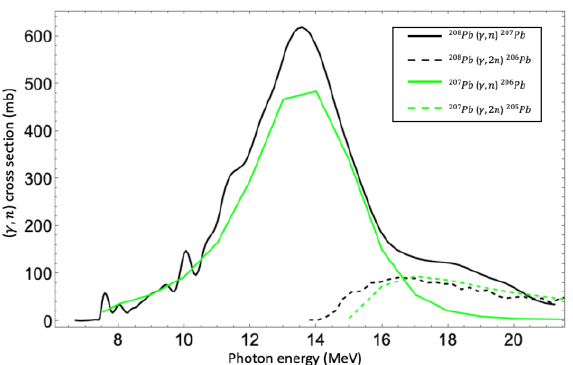
Figure 2. Photonuclear cross-section for two isotopes of lead, obtained from the END-F and TENDL cross-sectional libraries.